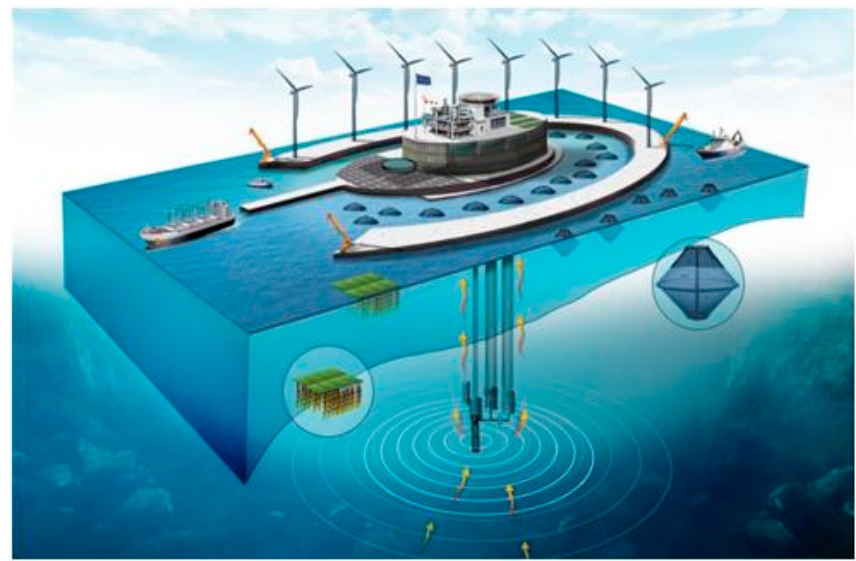
Figure 1. Green and Blue Concept (Fernando Montecruz for the Modular Multi-use Deep Water Offshore Platform Harnessing and Servicing Mediterranean, Subtropical, and Tropical Marine and Maritime Resources (TROPOS) project. (http://www.troposplatform.eu)).